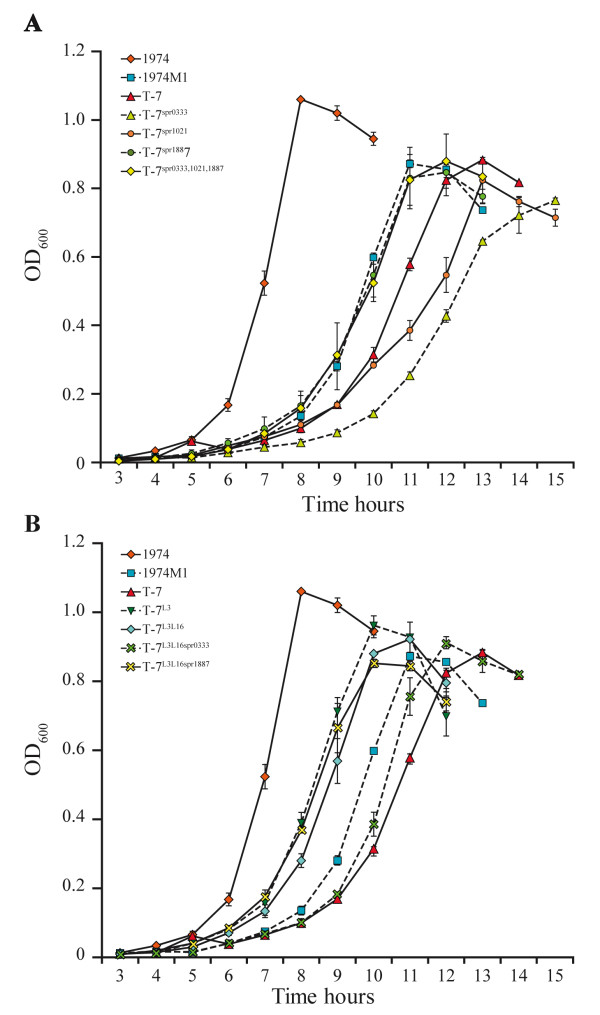
Growth kinetics of S. pneumoniae wild-type (1974), LNZ-resistant mutant (1974M1) and LNZ-resistant transformants. A. Growth curves of S. pneumoniae 1974 transformed with four mutated copies of 23S rRNA alone (T-7); or along with altered versions of spr0333 (T-7spr0333); spr1021 (T-7spr1021); spr1887 (T-7spr1887); or a combination of the three (T-7spr0333, 1021, 1887). B. Growth curves of S. pneumoniae 1974 transformed with four mutated copies of 23S rRNA alone (T-7); or along with altered versions of spr0188 (T-7L3); spr0188 and spr0196 (T-7L3L16); spr0188, spr0196 and spr0333 (T-7L3L16spr0333); or spr0188, spr0196 and spr1887 (T-7L3L16spr1887). Data are expressed as the mean of three independent experiments and the statistical significance of the growth differences are indicated in the text.